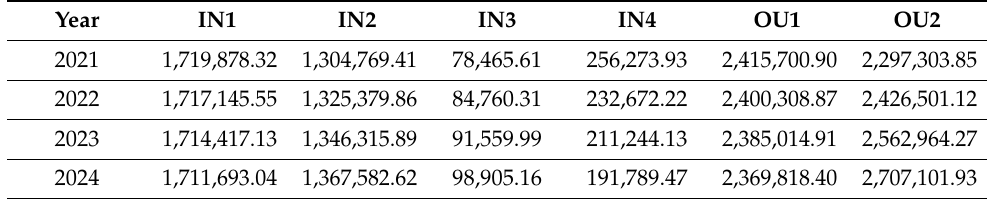
Table 14. Forecast results of LO10 (calculated by